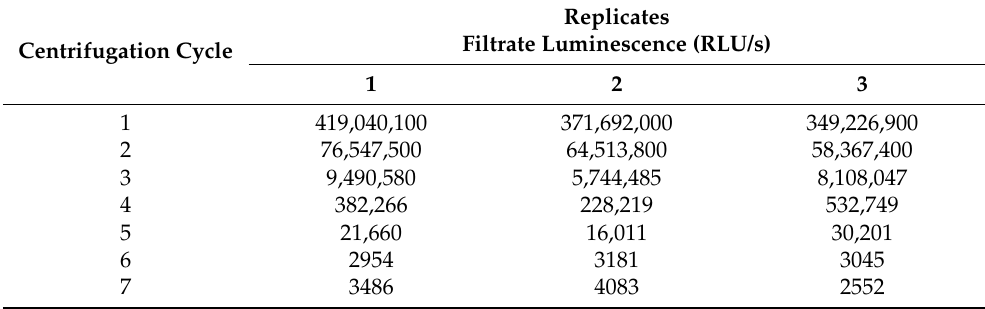
Table 1. Removal of NanoLuc ® Luciferase from Φ V10 nluc through seven rounds of centrifugal filtration. Luminescence (relative light units per second, RLU/s) was measured for 10 µ L of Φ V10 nluc filtrate after each consecutive centrifugation/filtration cycle for three separate phage preparations.